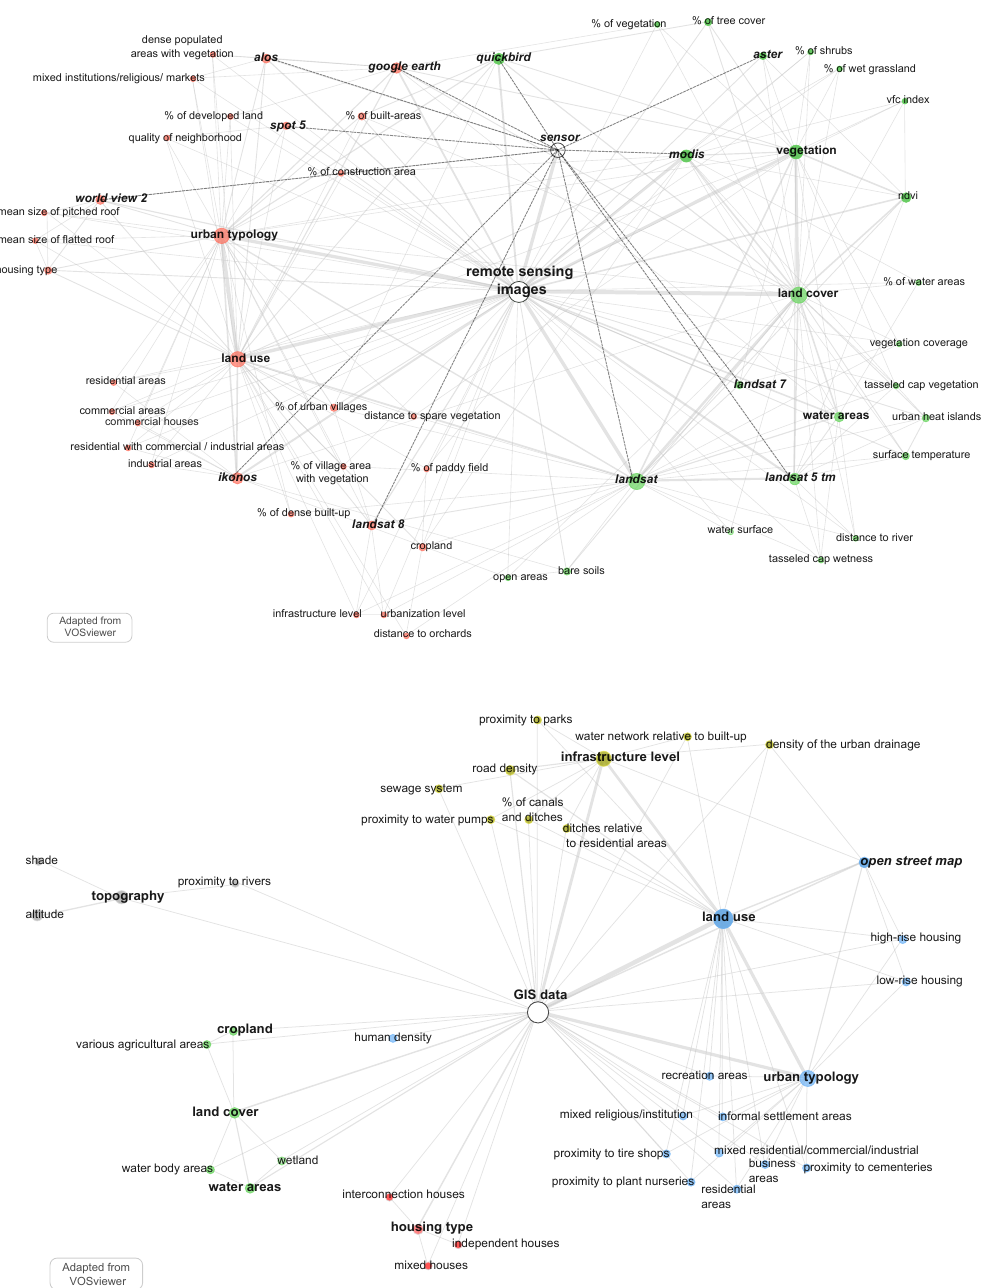
Figure 5. Co-occurrences network mapping of the self-defined keywords related to the articles using remote sensing images ( top ) and Geographic Information System (GIS) ( bottom ) to produce the landscape